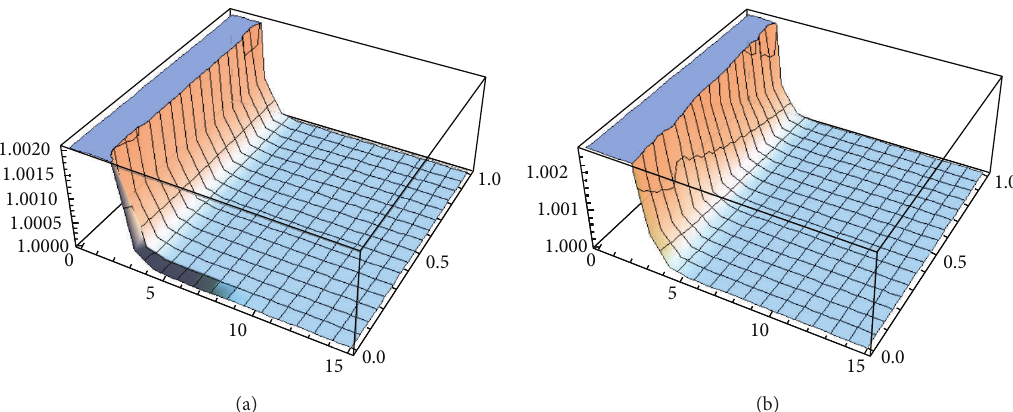
Figure 9: Graph of the solution (37) corresponding to the values 𝛼 = 0.05 , 𝛼 = 0.85 , respectively, when 𝑘 = 1 , 𝑝 = 2 , 𝛽 = 3 , 0 < 𝑥 < 15 , and 0 < 𝑡 < 1 .